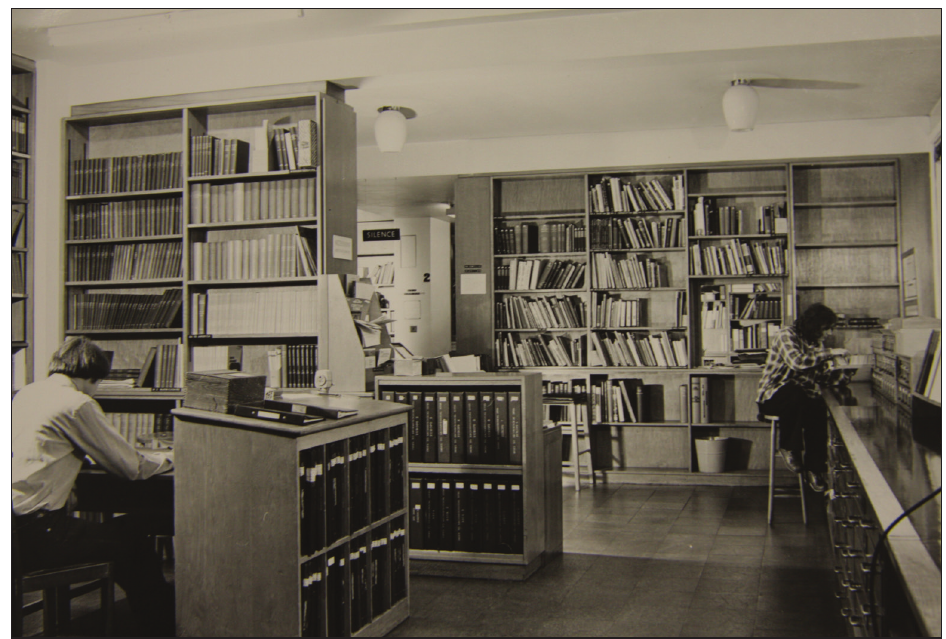
Figure 4: The First Floor Gordon Square Library (Photo UCL Institute of